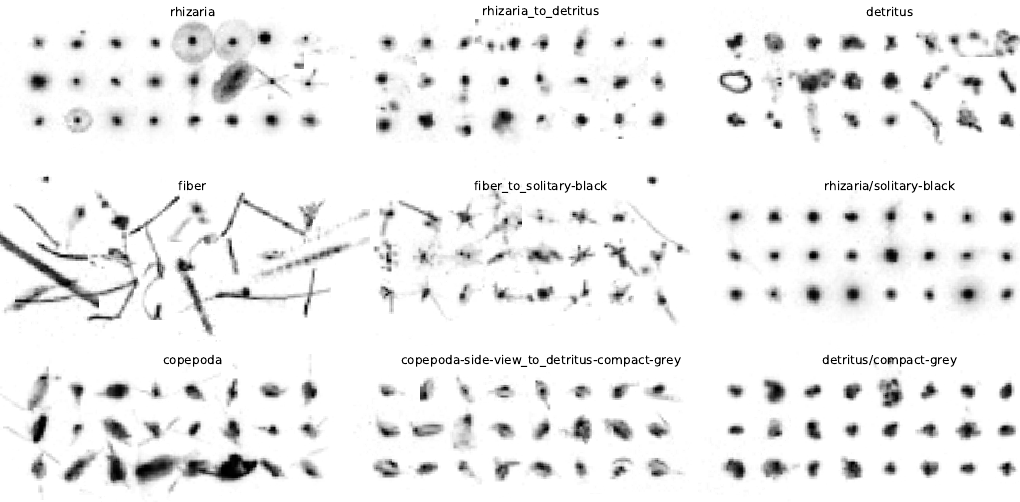
Figure 9. Some classes defined using MorphoCluster (“X_to_Y”, middle column) form a transition between two clear-cut